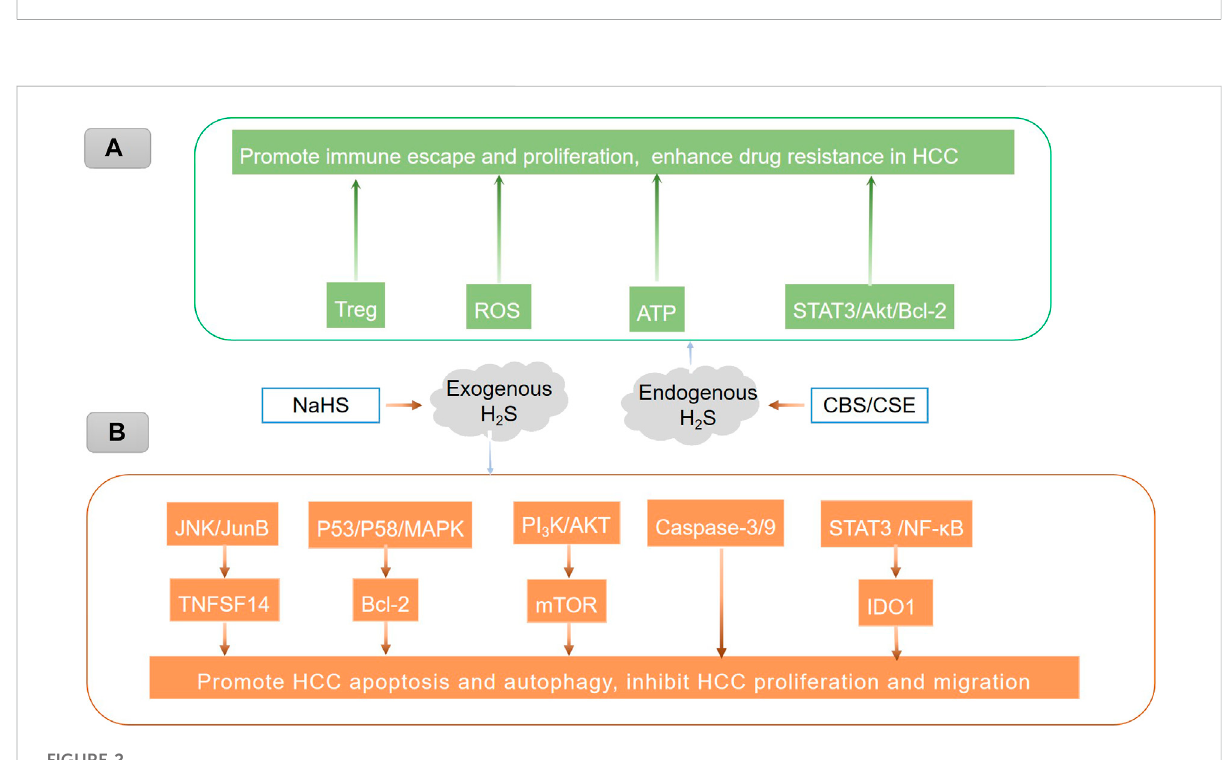
FIGURE 2 EndogenousandexogenousH 2 SplaydifferentrolesinHCCthroughdifferentmechanisms. (A) EndogenousH 2 Spromotesimmuneescapeand proliferation and enhances drug resistance in HCC, which may berelated to thepromotion of Treg-mediatedimmune evasion (Xu et al.,2021; Zhou et al., 2021), the stimulation of ATP production (Fortibui et al., 2021), and the activation of the STAT3/Akt/Bcl-2 pathway (Wang et al., 2018). The inhibition of reactive oxygen species (ROS) (Wang et al., 2018). (B) Treatment of hepatoma cells with exogenous H 2 S could induce HCC cell